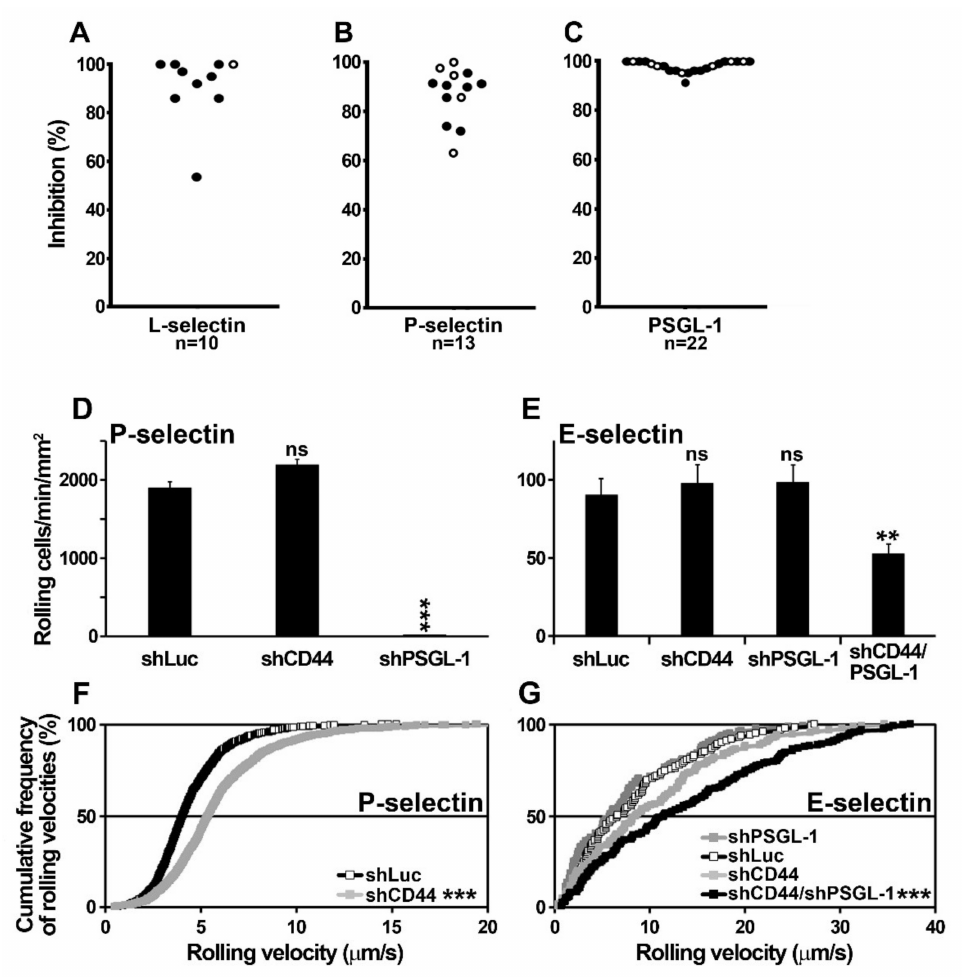
Figure 4. P-selectin glycoprotein ligand-1 (PSGL-1) and additional ligands mediate blast cell rolling on L-selectin and endothelial selectins. Myeloblasts ( (cid:8) ) or lymphoblasts (